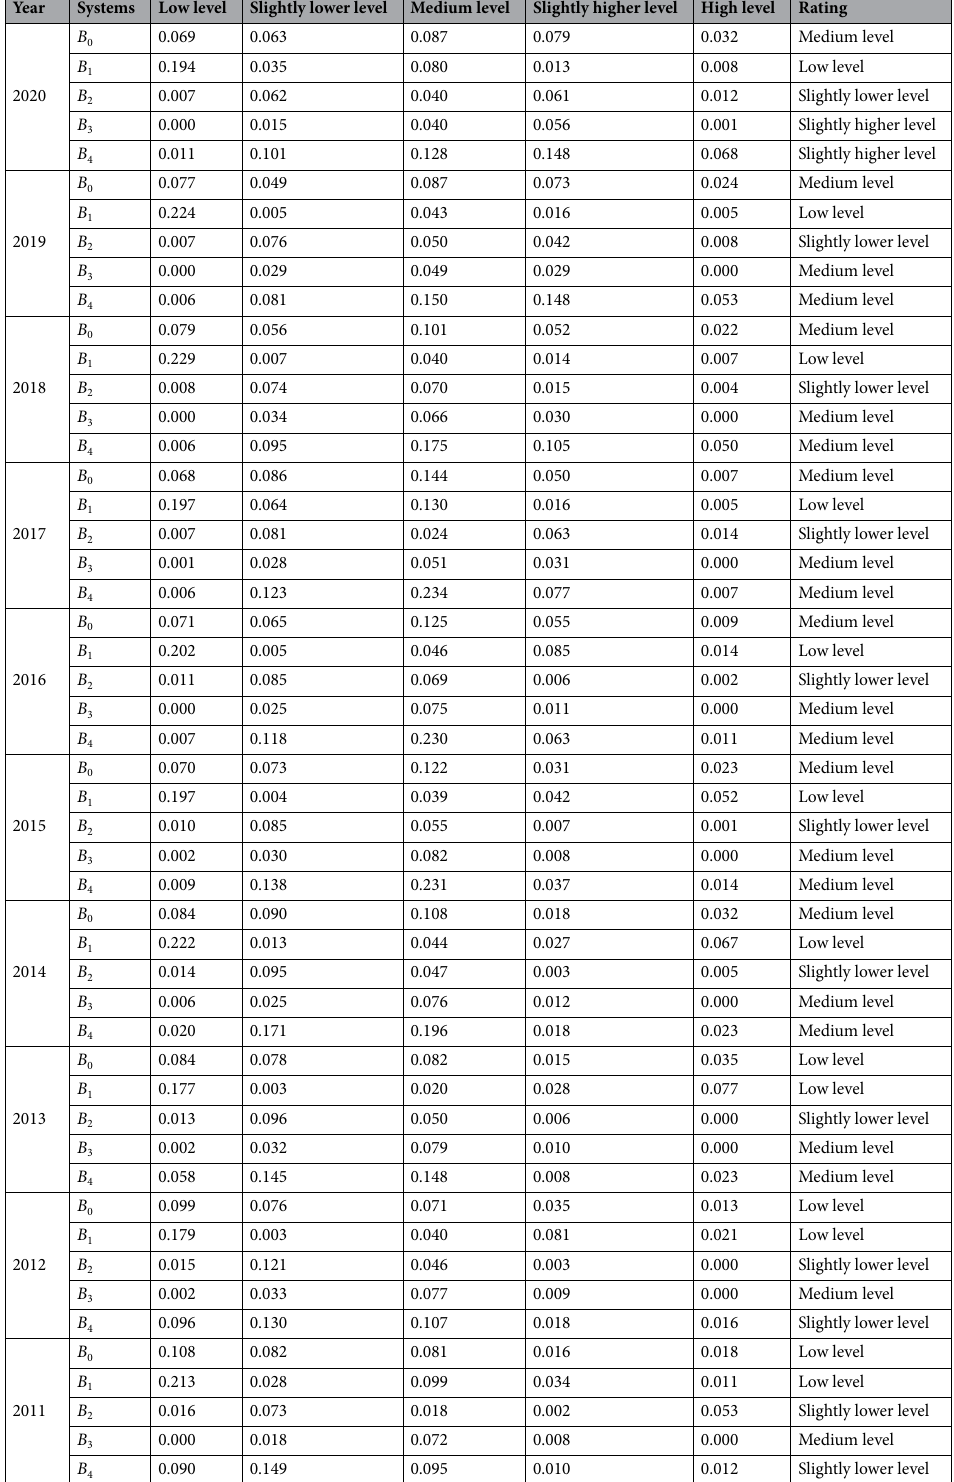
Table 11. Comprehensive assessment results of resilience